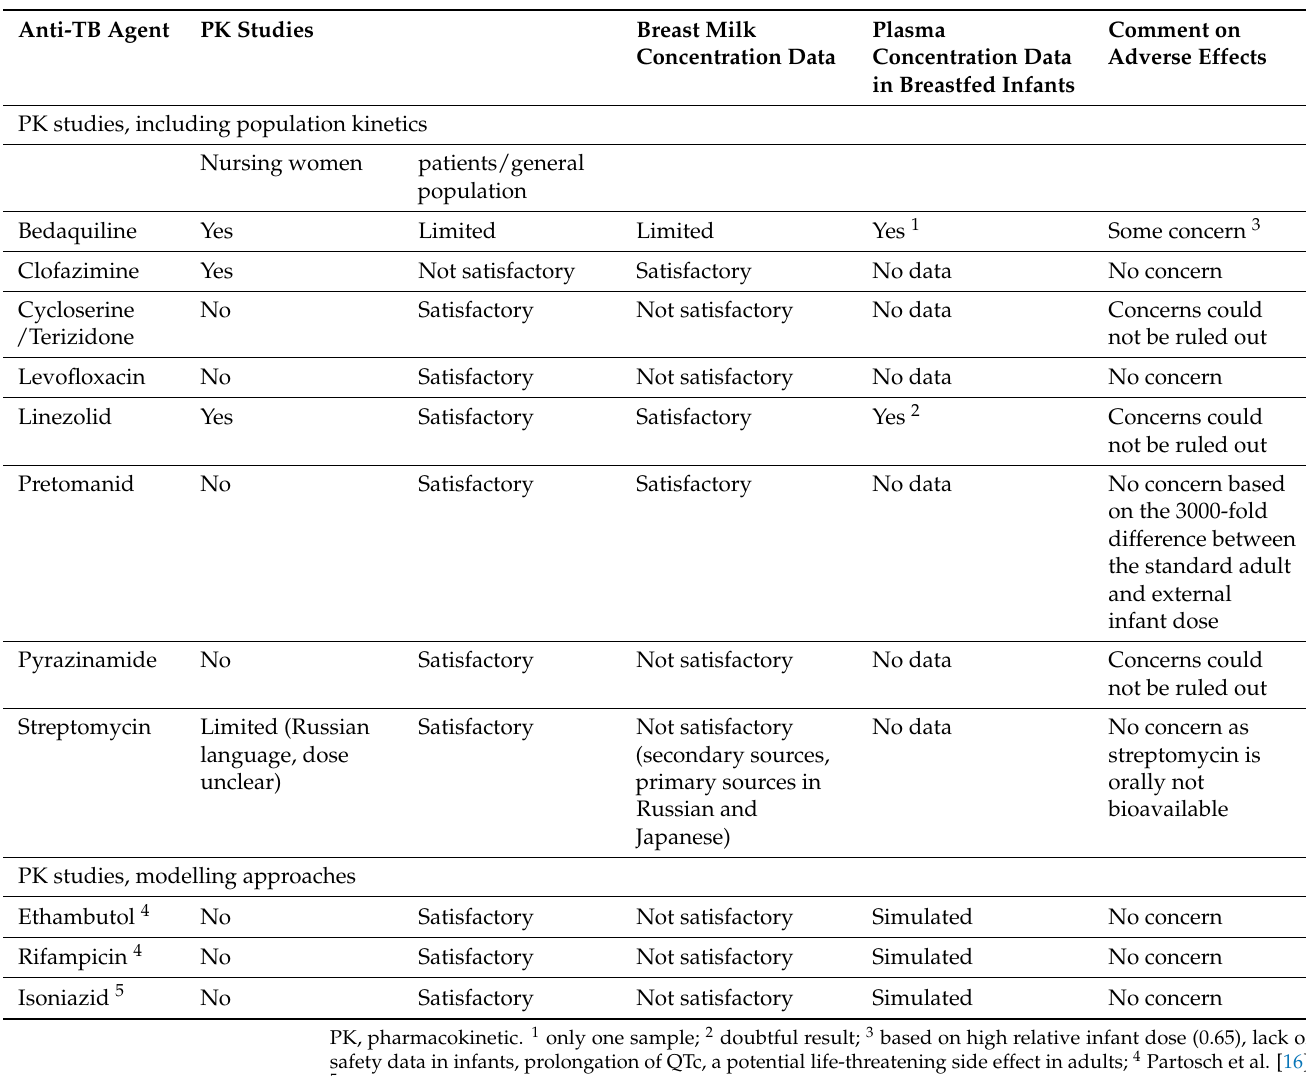
Table 2. Overview on the results of the